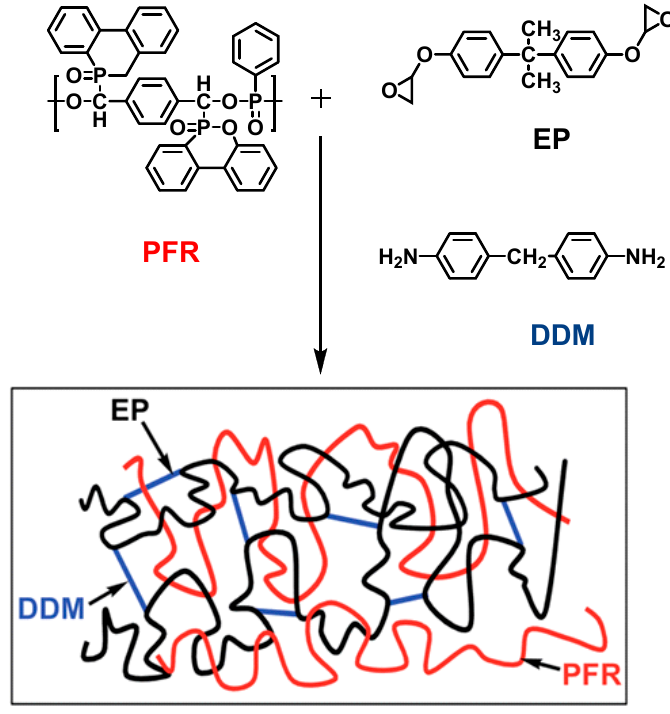
Figure 2. Preparation of polyphosphate flame retardant-epoxy resin (PFR-EP) semi-interpenetrating polymer network (SIPN) composites. Readapted with permission from Ref. [67], Copyright 2014, The Royal Society of Chemistry.